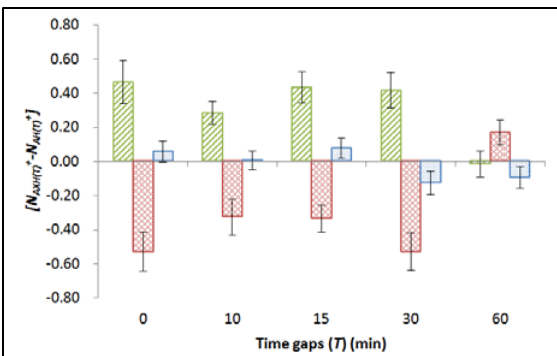
Figure 2. Differences between the net normalized apoptotic counts ( N AXH(T) + − N AH(T)+ ) on zebrafish embryos at 20 hpf (diagonally filled), 24 hpf (filled with diamond), and 30 hpf (filled with dots), which had been irradiated with an alpha-particle dose of 4.4 mGy at 5 hpf and an X-ray dose of 10 mGy, with T = 0, 10, 15, 30, or 60 (min) between the alpha-particle and X-ray irradiations. Error bars represent the standard errors. Table 1. ANOVA and post-hoc t-test results obtained among N AX24(T) + , N A24(T) + , and N C24(T) + , with time gaps T = 0, 10, 15, 30, or 60 (min) between the alpha-particle and X-ray irradiations, and with apoptotic counts determined at H = 24 (hpf).